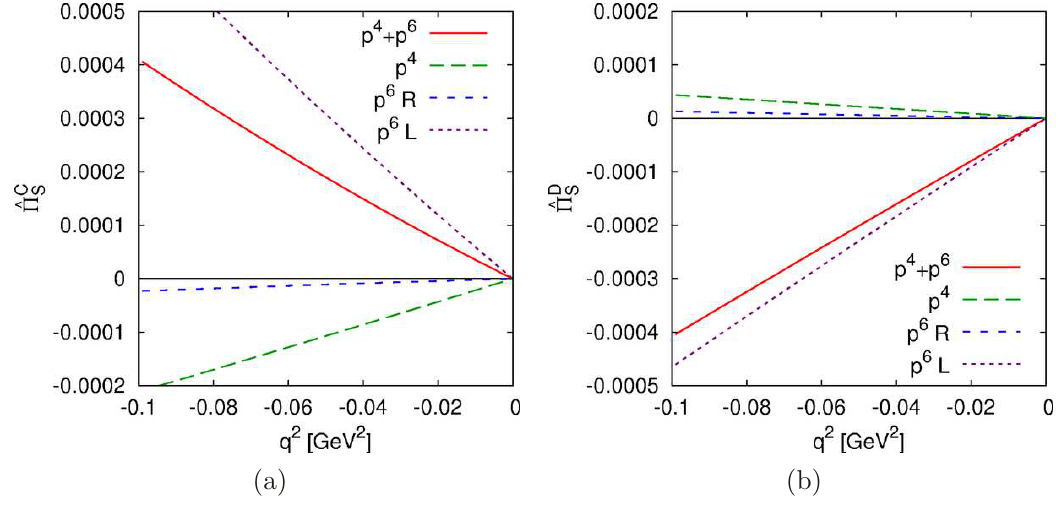
Figure 2 . (a) The different contributions to the connected part, ˆΠ C pure two-loop part, p 6 R , and the p 6 part depending on the p 4 LECs, p 6 L . The pure LEC contri- bution as estimated by V MDφ is not shown. (b) The different contributions to the disconnected ( q 2 ). The V MDφ contribution is zero for this part ˆΠ D S